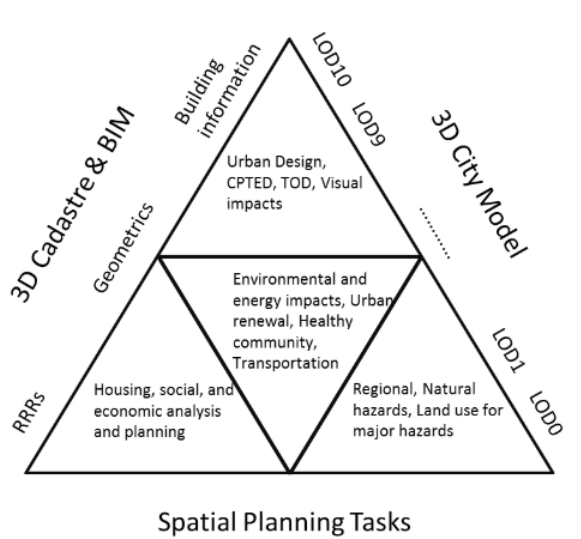
Figure 1 3D data models and spatial planning tasks. Source: